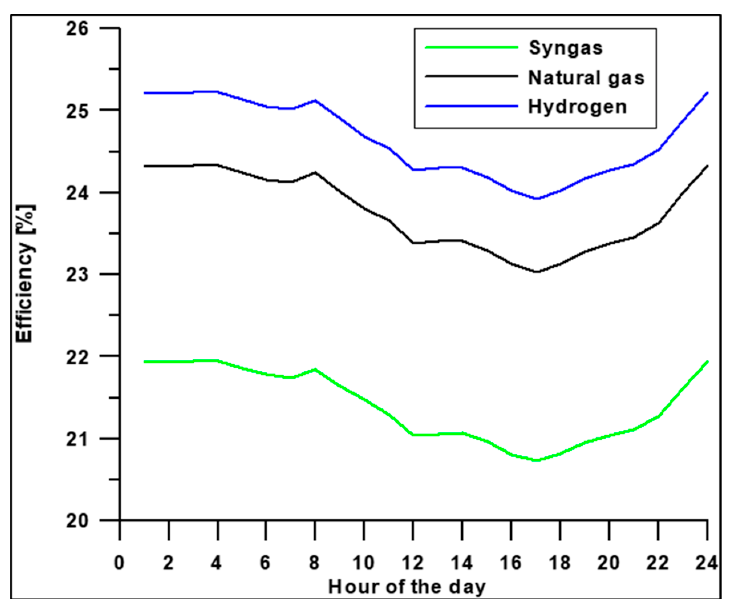
Figure 9. Thermal E ffi ciency (LHV) calculated for the three fuels. Energies 2020 , 13 , x FOR PEER REVIEW Figure 9. Thermal Efficiency (LHV) calculated for the three fuels.